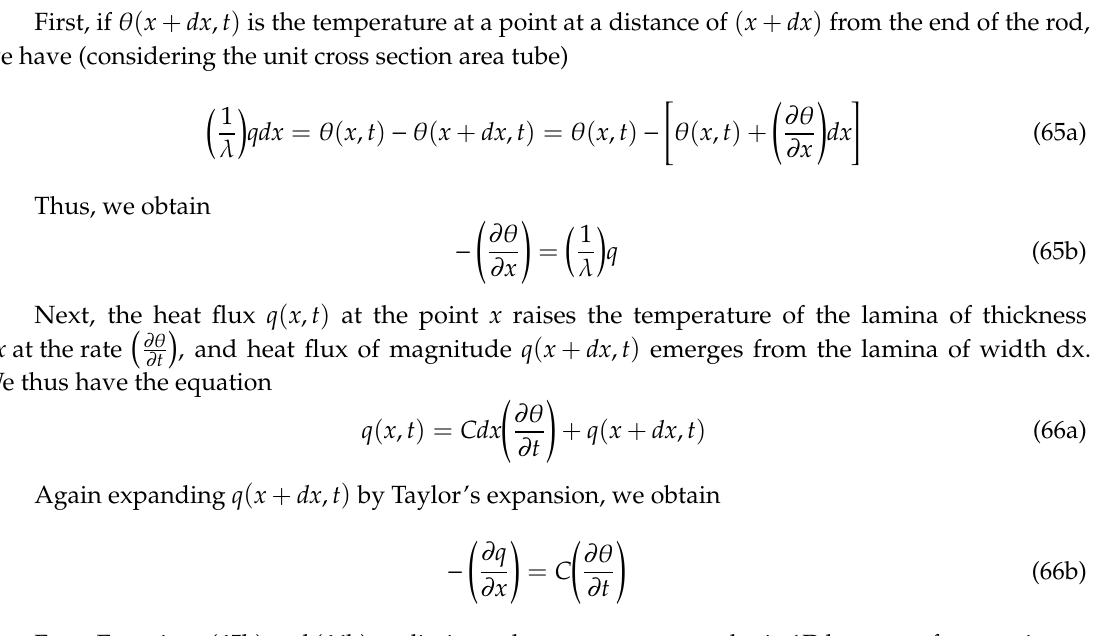
Figure 6. ( a ) 1D thermal di ff usion model, ( b ) experimental setup for determining directional thermal di ff